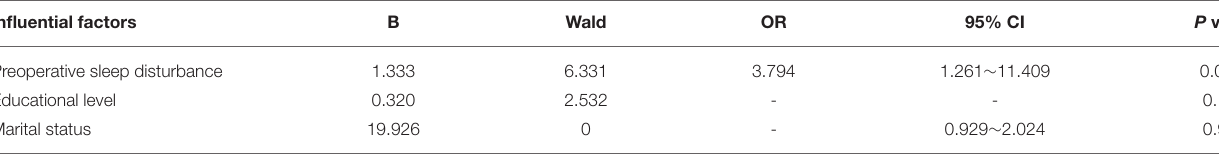
TABLE 5 | Logistic regression analysis of moderate or above pain at 1 month after surgery ( n = 87). Influential factors B Wald